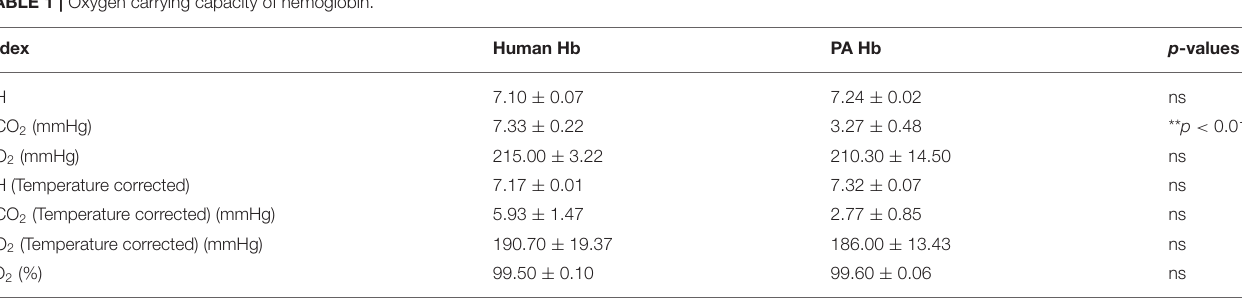
TABLE 1 | Oxygen carrying capacity of hemoglobin.